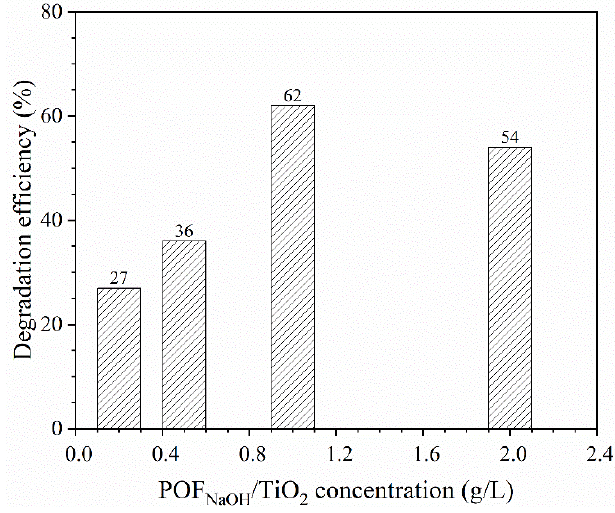
Figure 8. Effect of POF NaOH /TiO 2 concentration ([Phenol] 0 = 50 mg/L; λ = 254 nm; V phenol = 50 mL; pH = 6.7, t = 4 h).